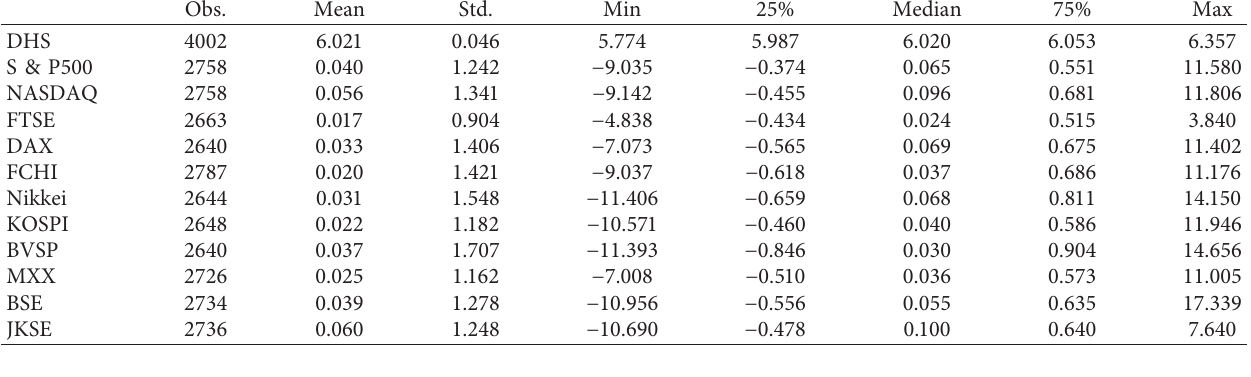
Table 1: Descriptive statistics: DHS and return (%) of financial market indices.